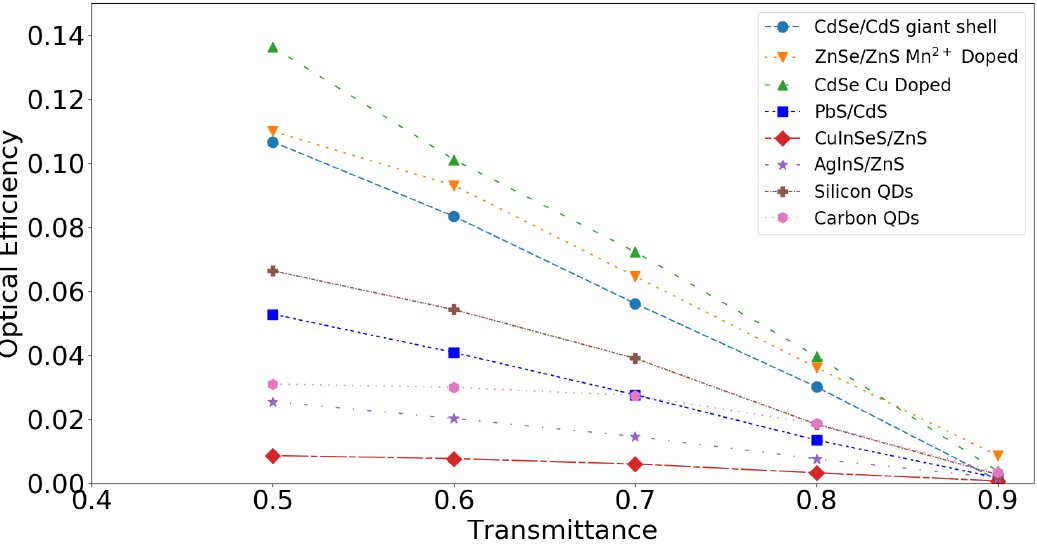
Figure 13. Optical efficiency, plotted against T vis